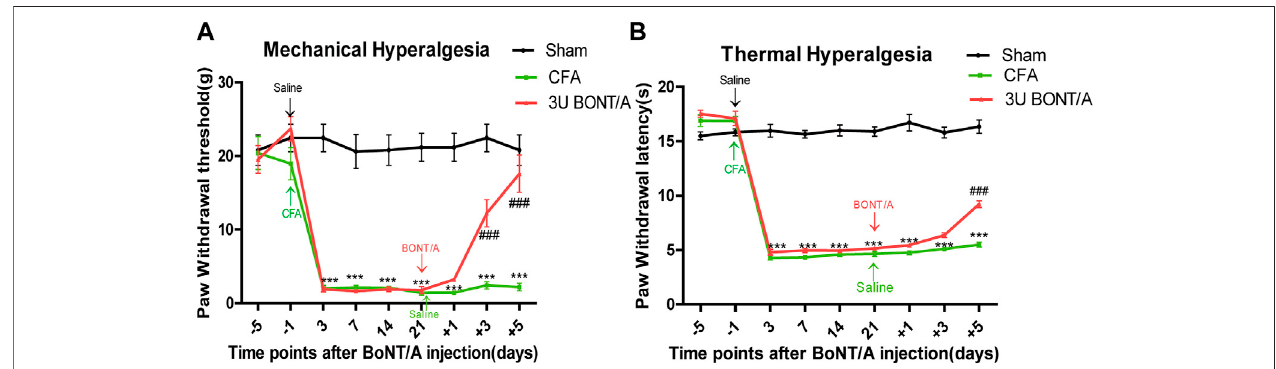
FIGURE 1 | (A) Mechanical allodynia presented by paw withdrawal threshold (PWT). (B) Thermal hyperalgesia presented by paw withdrawal latency (PWL). The mechanical allodynia and thermal hyperalgesia were signi fi cant decreased after CFA injection. After BoNT/A application, PWT signi fi cantly increased at doses of 3 U at 5 days, and PWL also displayed similar results (*** p < 0.001 represents comparison of CFA with the sham group, ### p < 0.001 represents comparison of 3 U CFA+BoNT/A with the CFA group).